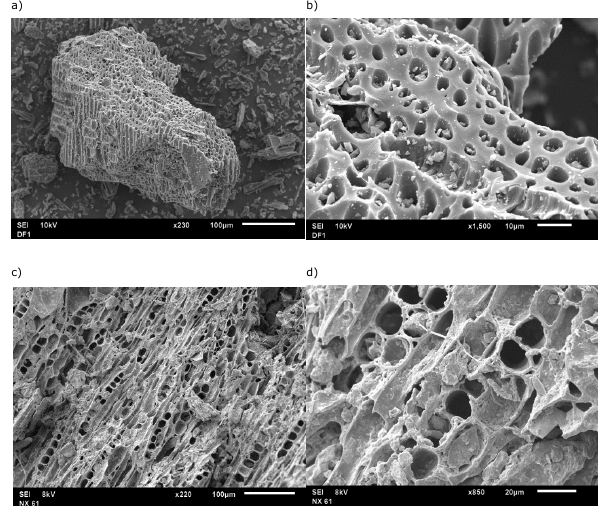
Figure 2. High-resolution images of Eucalyptus wood biochar (par- Figure 2. High resolution images of Eucalyptus wood biochar (particle size ≤ 2000 μm) before ticle size ≤ 2000µm) before application (a, b) and 2 years after application (a, b) and 2 years after application into a sandy Dystric Plinthosol (c, d). application into a sandy Dystric Plinthosol (c, d) . Images made at LABMIC, Institute of Physics, Federal University of